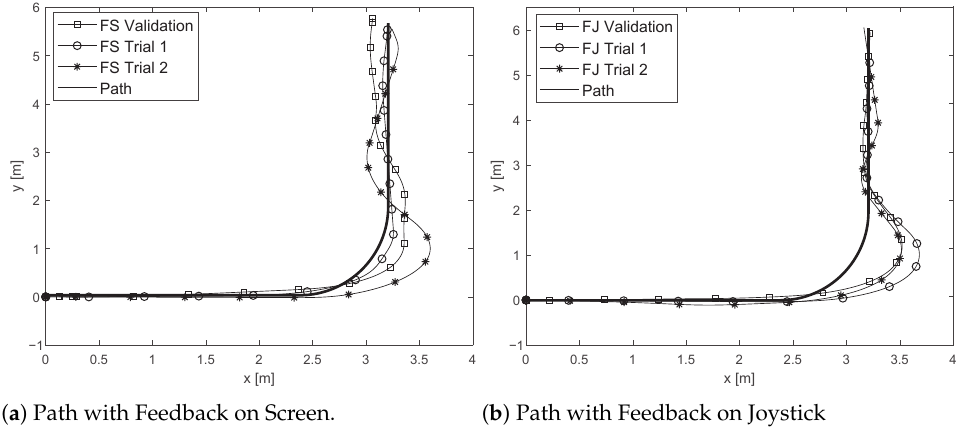
Figure 5. Path following task examples for one subject. Training and validation trials for ( a ) feedback on the screen and ( b ) feedback on the joystick are